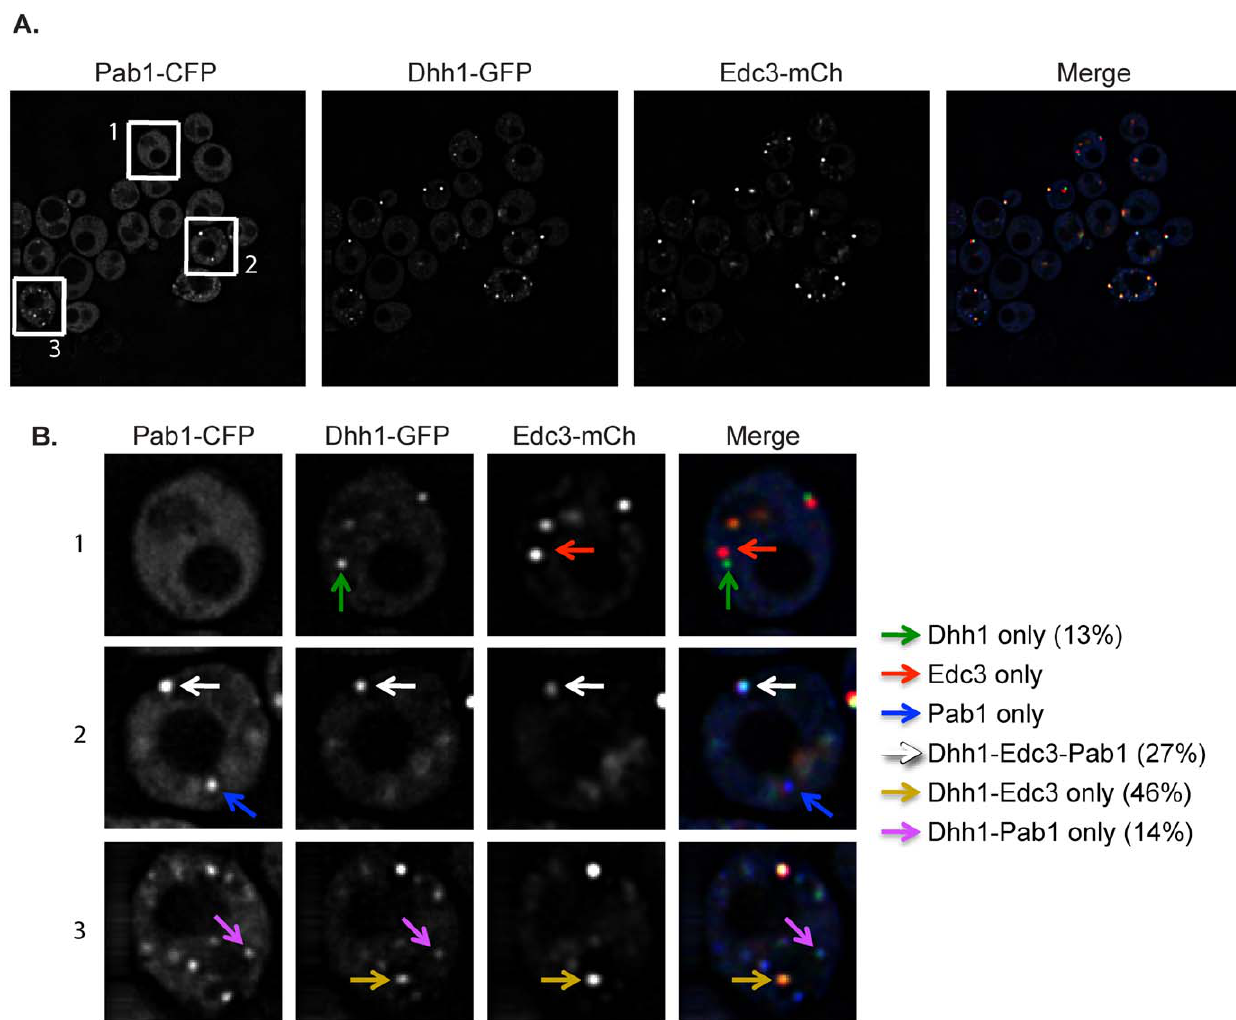
Figure 2. Dhh1 localizes to both P-bodies and stress granules following glucose deprivation stress. (A) A strain harboring a Dhh1-GFP integration was transformed with a plasmid containing Edc3-mCherry and Pab1-CFP and assayed for GFP co-localization with mCherry and/or CFP upon glucose deprivation. (B) A closer view of three sample cells, labeled accordingly in A, is shown. Dhh1 co-localized with Edc3-mCherry (gold arrows), Pab1-CFP (purple arrows), and both Edc3-mCherry and Pab1-CFP (white arrows). Dhh1 was also found in independent foci (green arrows).